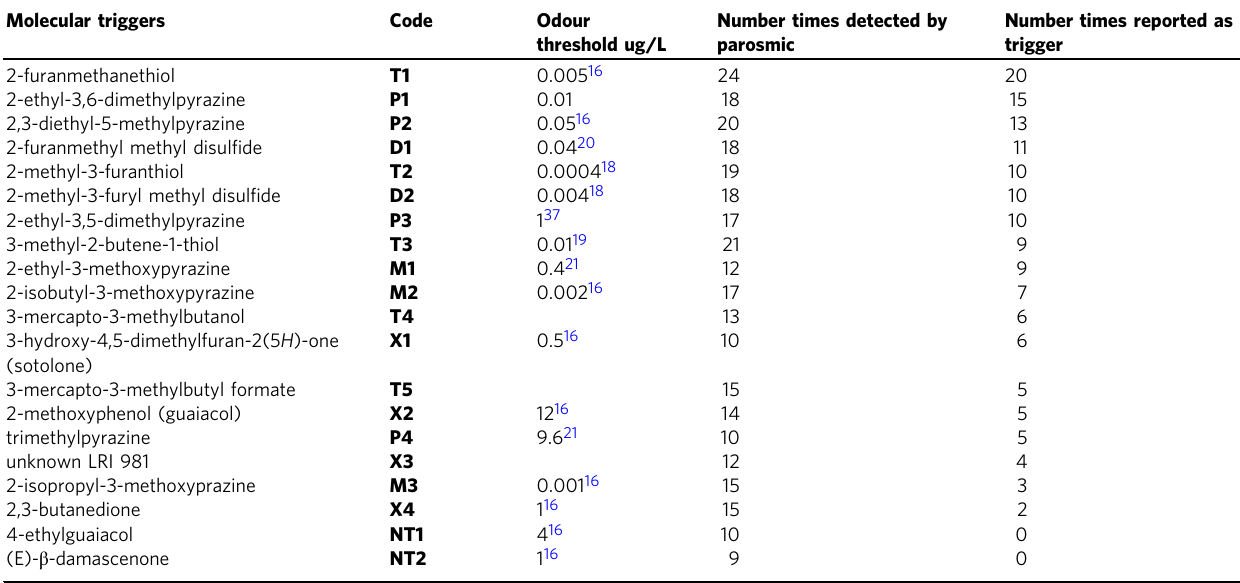
Table 2 Compounds most frequently detected by parosmic participants. Molecular